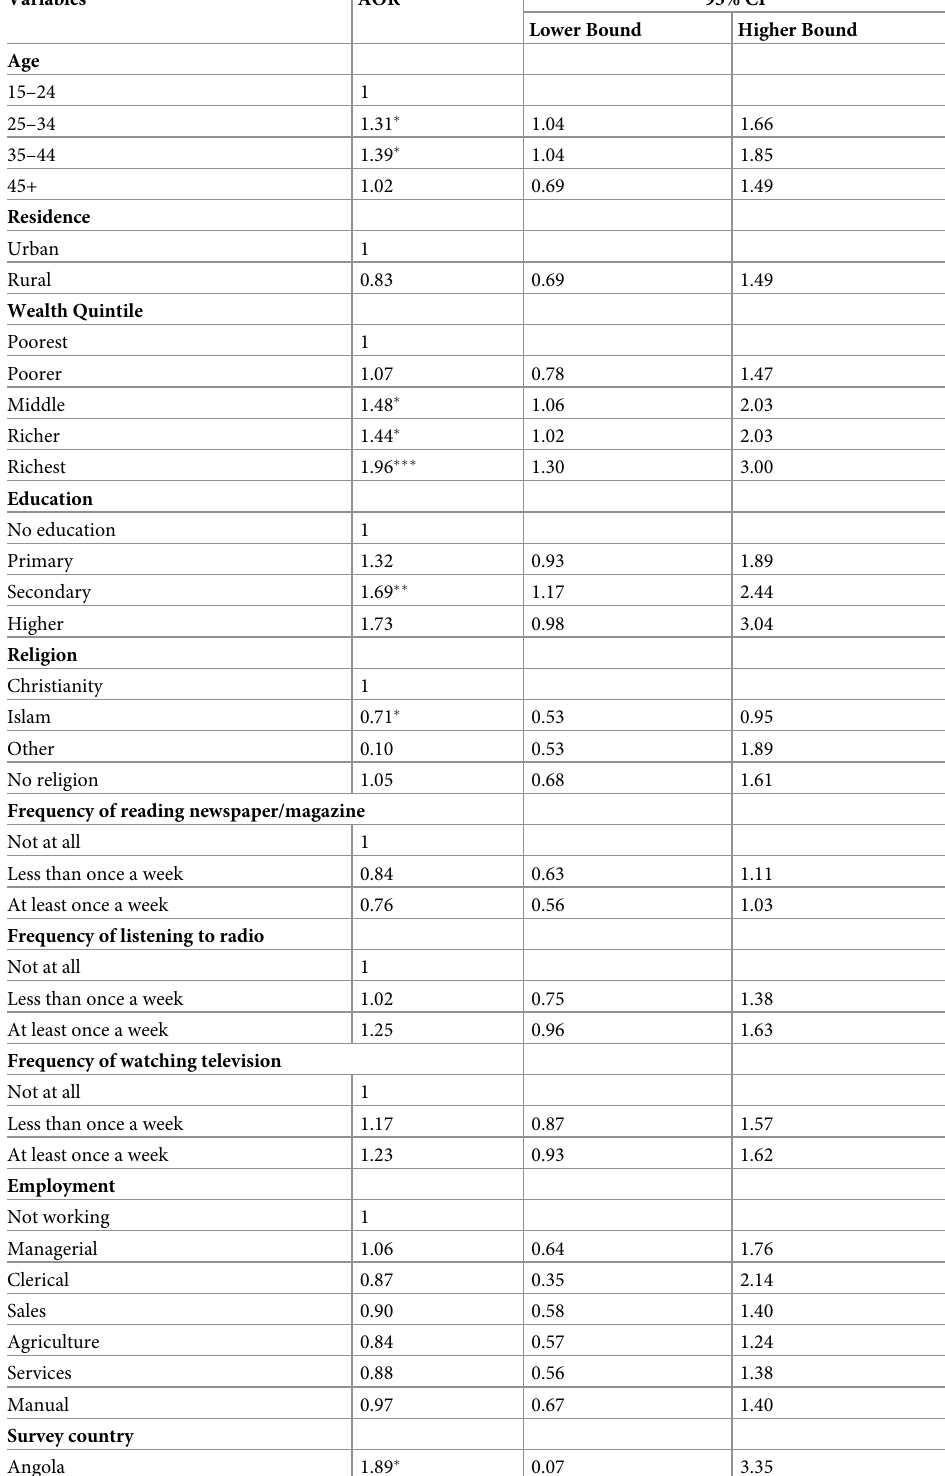
Table 2. Multivariable logistic regression analysis on the factors that influence consistent condom use among men who pay for sex in